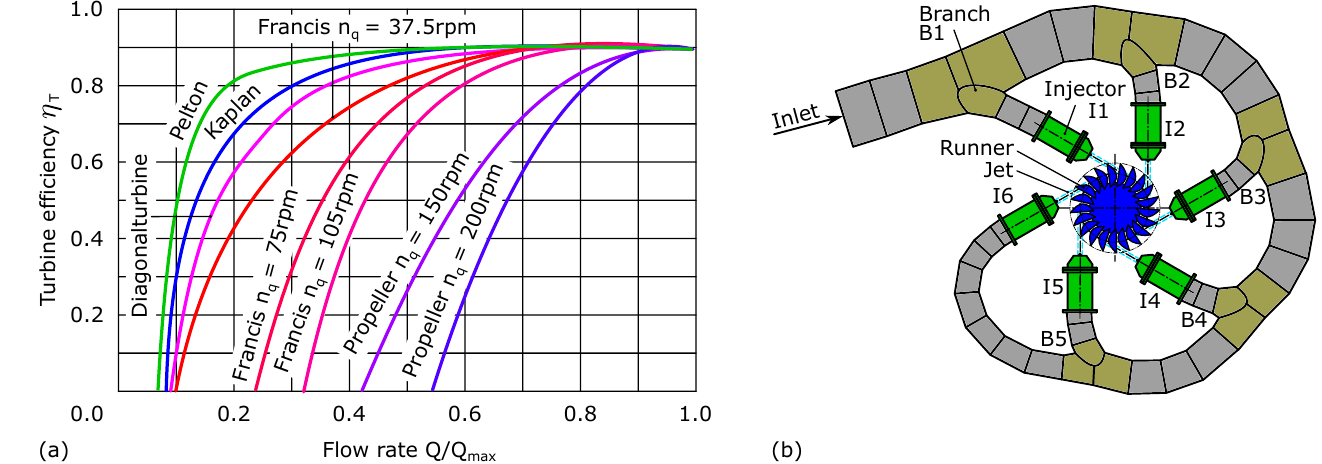
Figure 1. Curves of turbine efficiency η T against the flow rate Q normalised by the maximum flow rate Q max for common turbine types, recreated and modified from [10] ( a ). Explanatory sketch for Pelton turbines with conventional distributor system ( b